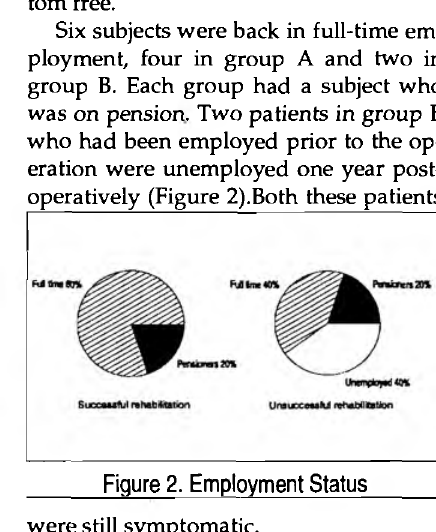
Figure 5. Knowledge of Medication